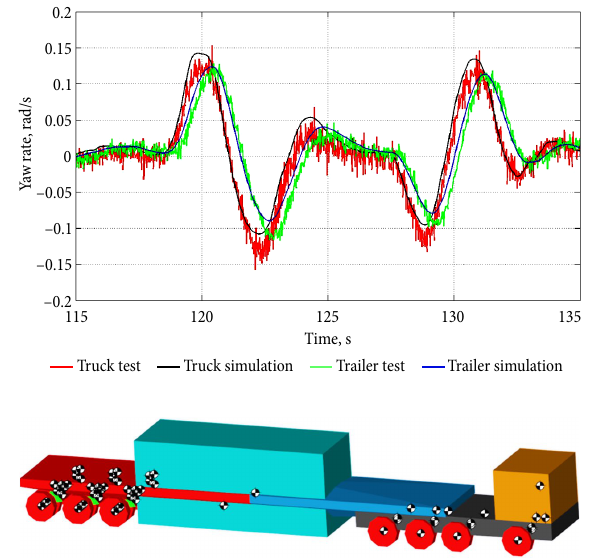
Fig. 8. Vehicle dynamics validation